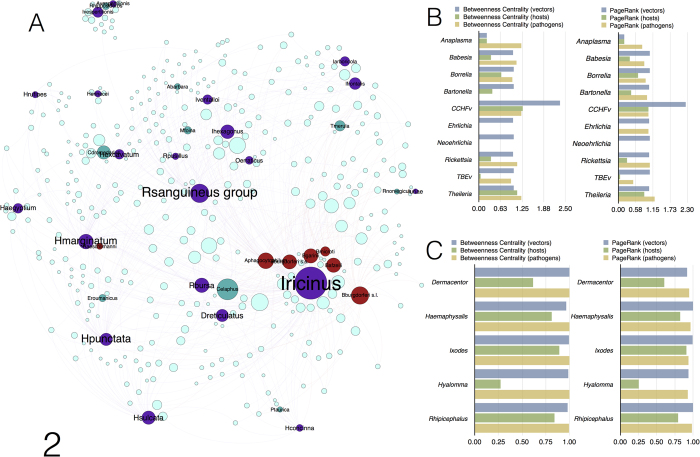
Data about bridge species that support the connections among subnetworks(a) Localization of the bridge species in the network structure. Ticks, blue; vertebrates, grey; pathogens, brown. (b) Changes in the NBC and PR of pathogens after the removal of vertebrates that act as bridge species. (c) Changes in the NBC and PR of ticks after the removal of vertebrates that act as bridge species. In (b) and (c), histograms reflect the rates of change (1 = no change).